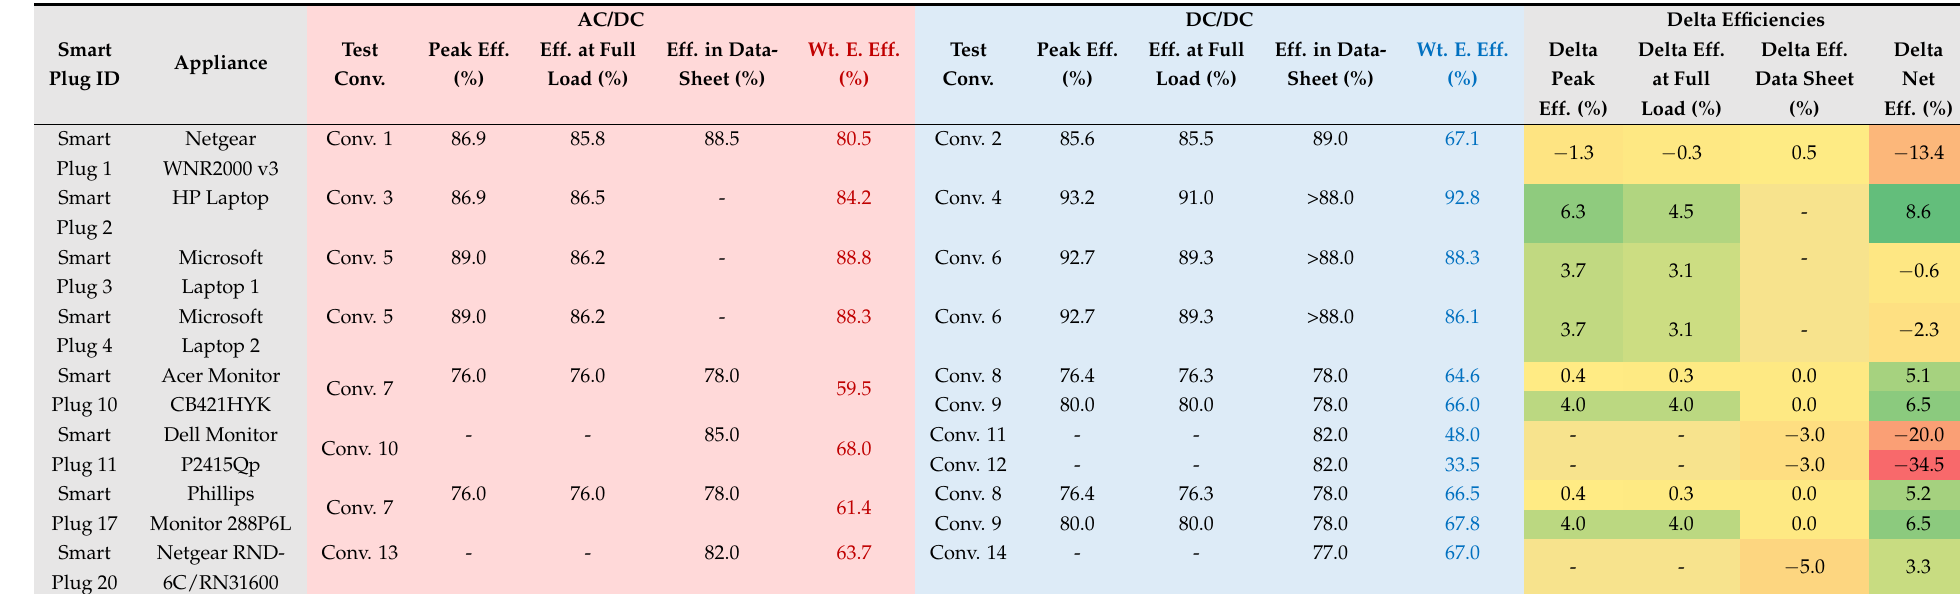
Table 10. AC vs. DC endpoint efficiency